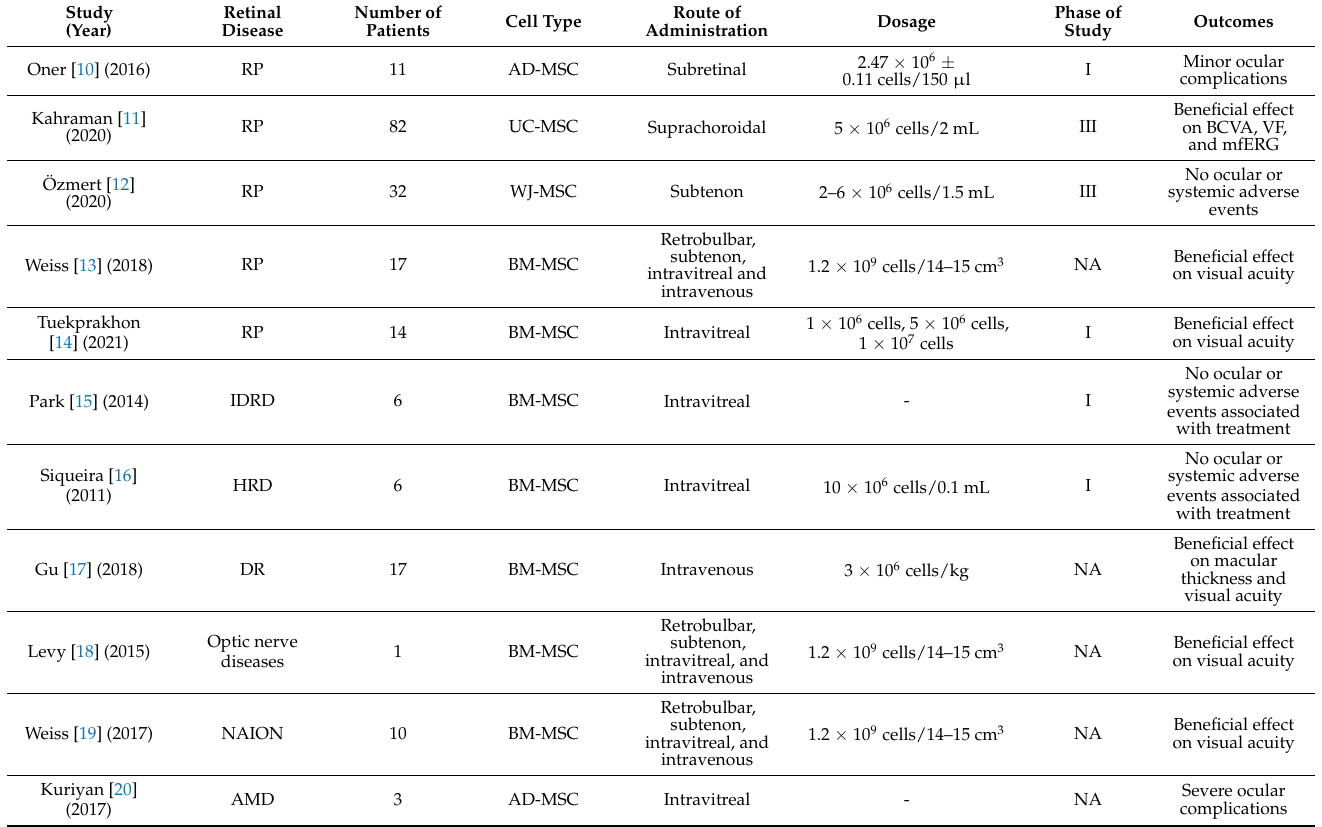
Table 1. MSC-based treatment in clinical trials for retinal